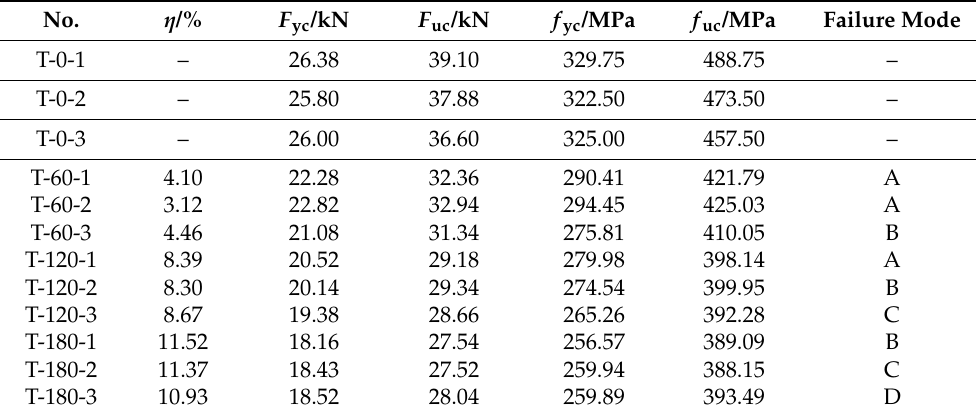
Table 4. The strength of tensile test.